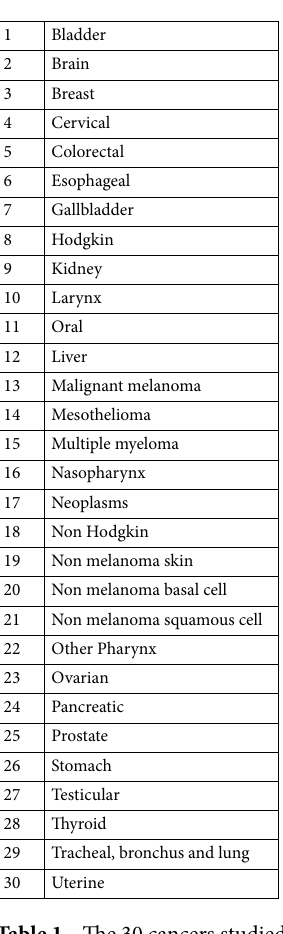
Table 1. The 30 cancers studied in alphabetical